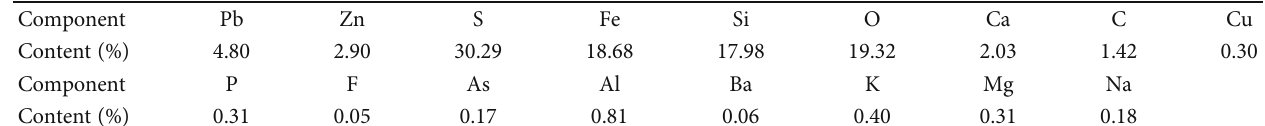
Figure 1: X-ray di ff raction pattern of lead-zinc ore for grinding test. Table 1: Main chemical composition of lead-zinc ore.